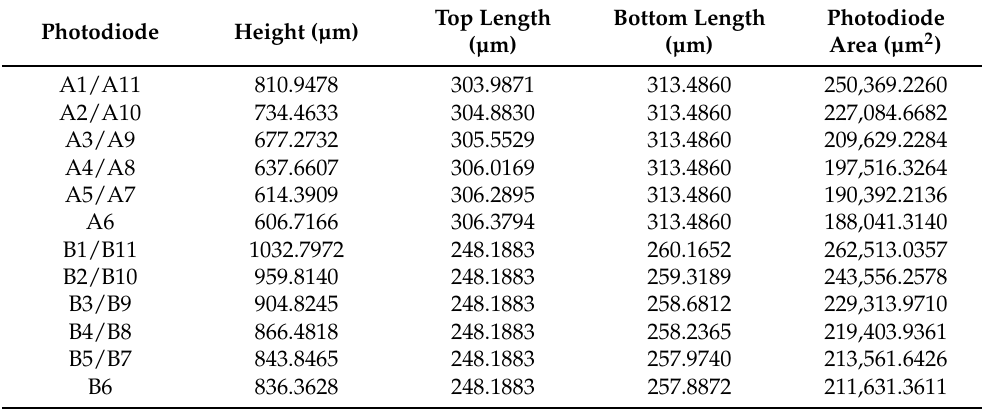
Table 1. Size information of photodiodes at each position of M arrays after area